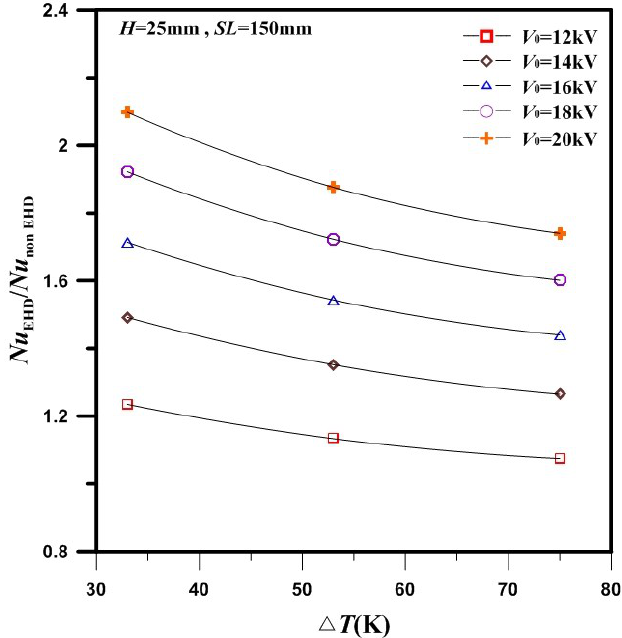
Figure 12. Variations in Nu EHD / Nu nonEHD versus temperature differences Δ T for different applied voltages V 0 ( H = 25 mm and SL = 150 mm).